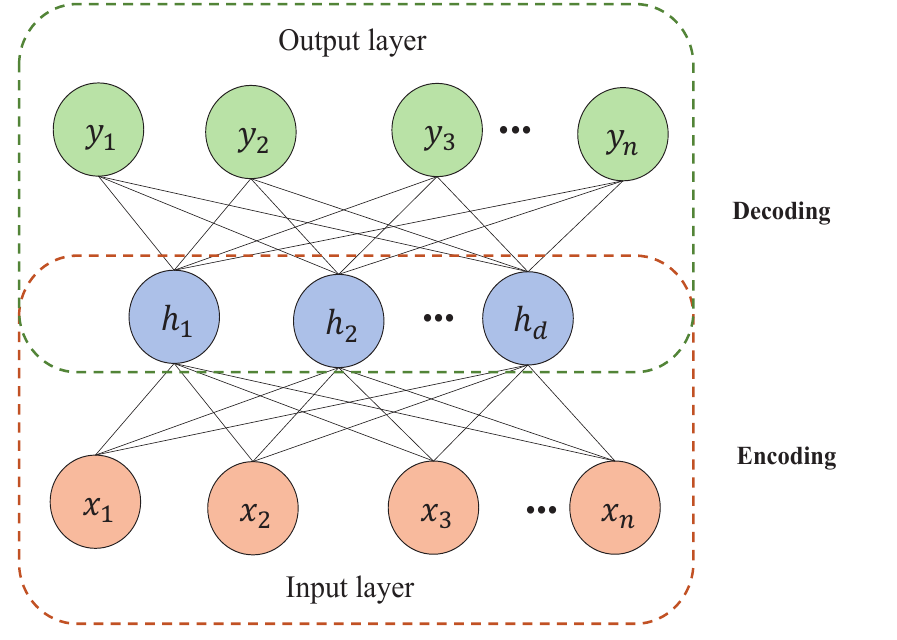
Figure 1. Structure diagram of AE